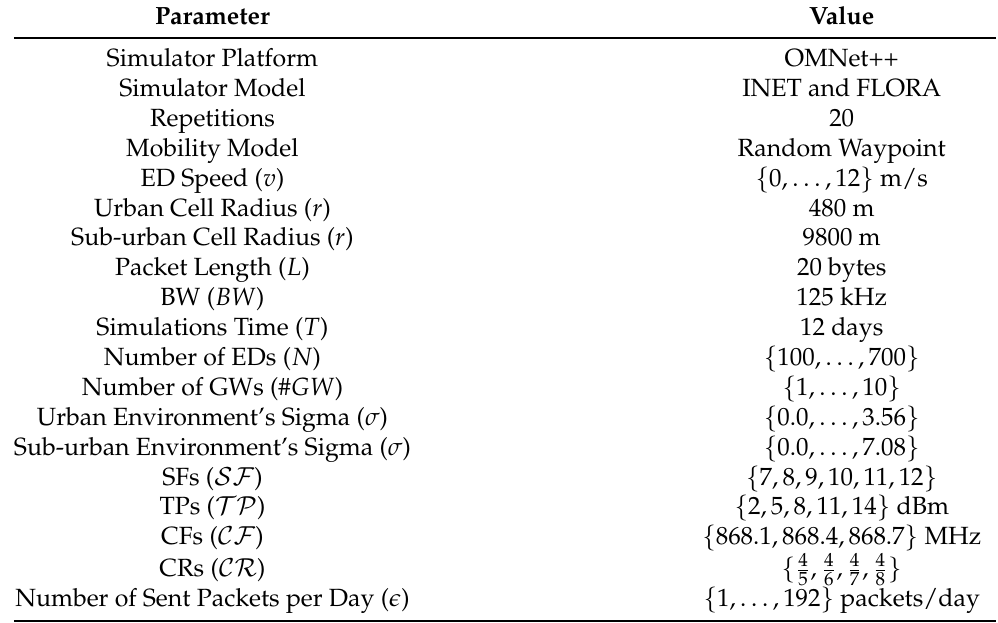
Table 1. Simulation Setup